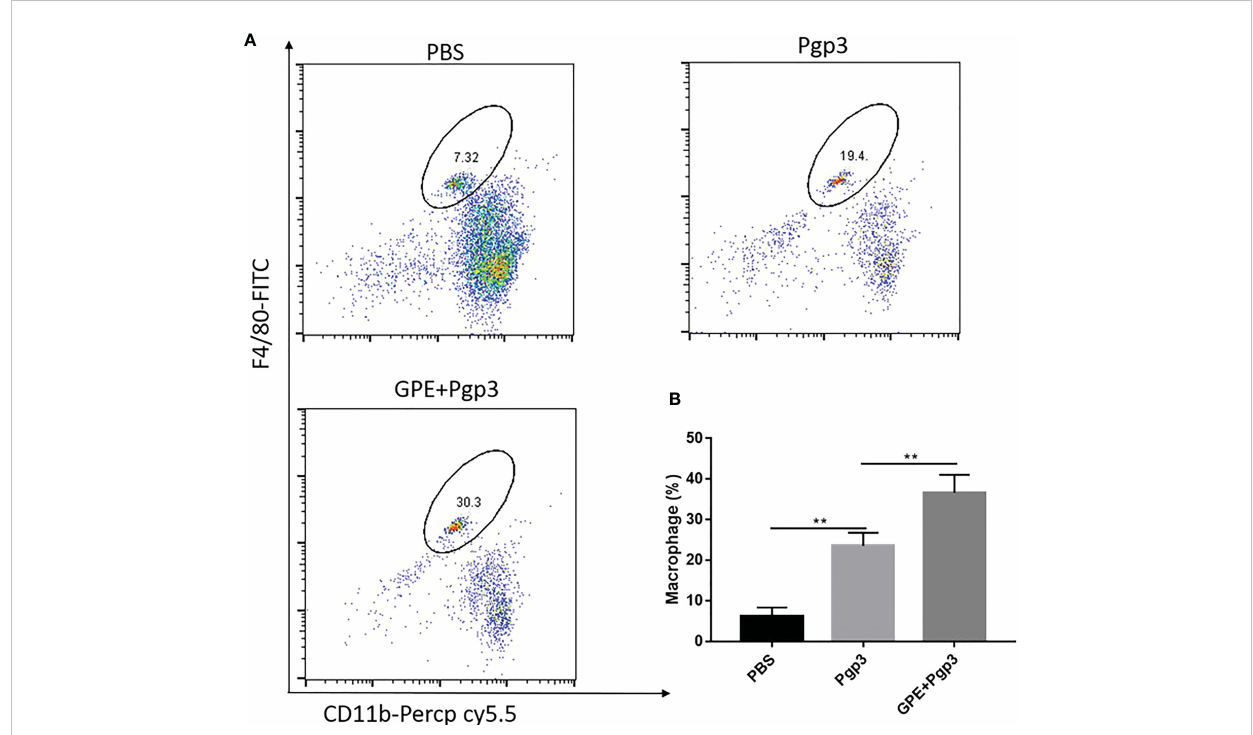
FIGURE 7 Macrophage recruitment at the injection site. Female BALB/c mice (n = 4) were injected with either NS, Pgp3 (50 m g), or GPE+Pgp3 (50 m g Pgp3 in 0.1 mL GPE). Flow cytometry analysis of CD11b + F4/80 + in representative mice (A) and statistical comparison (B) of macrophages 24 h post injection of GPE. GPE, GO-stabilized Pickering